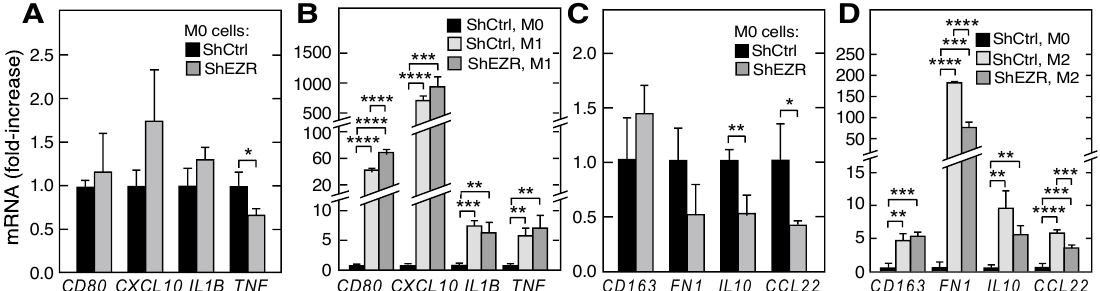
Figure 3. Role of ezrin in myeloid cell polarization. ( A ) mRNAs encoding M1 marker proteins CD80 , CXCL10 , IL1B , and TNF were determined by RT-qPCR in M0 ShEZR cells and normalized to M0 ShCtrl cells. ( B ) ShEZR cells and ShCtrl were subjected to M1 polarization conditions, and mRNAs encoding M1 marker proteins determined as in ( A ) and normalized to M0 ShCtrl cells. ( C ) mRNAs encoding M2 marker proteins CD163 , FN1 , IL10 , and CCL22 were determined by RT-qPCR in M0 ShEZR cells and normalized to M0 ShCtrl cells. ( D ) ShEZR and ShCtrl cells were subjected to M2 polarization conditions and mRNAs encoding M2 markers determined as in ( C ) and normalized to M0 ShCtrl cells. Mean ± standard deviation; *, **, ***, and **** indicate p < 0.05, 0.01, 0.001, and 0.0001, respectively.